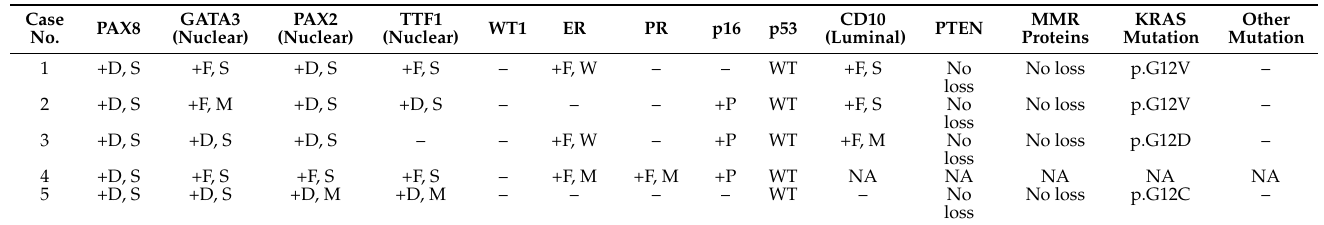
Figure 3. Histological features of ovarian MLA: Case 2. A 4.7-cm ovarian mass contained small, nodular components confined to the cyst. The mural nodules consisted of solid tumor tissue showing infiltrating small tubules in the background of the fibromatous stroma. These tubules were haphazardly arranged and anastomosed with each other, forming a cribriform or trabecular architecture. In addition to the small tubular pattern, the tumor cells formed irregular-shaped nests and cords, separated by thin intervening fibrous stroma. Hyaline-like eosinophilic secretions were occasionally noted within the tubular lumina and dilated duct-like structures. No severe nuclear pleomorphism was identified. The cystic lining was primarily composed of endometrial-like glands and stroma, the latter of which was occupied by hemosiderin-laden macrophages. Immunohistochemically, the tumor cells were focally positive for GATA3 with moderate staining intensity. PAX2 immunoreactivity was uniform and intense throughout the tumor. TTF1 expression was also diffuse and strong in most of the tumor cells. Hormone receptor expressions were absent, and loss of PTEN expression was not observed. Table 4. Immunostaining and targeted sequencing